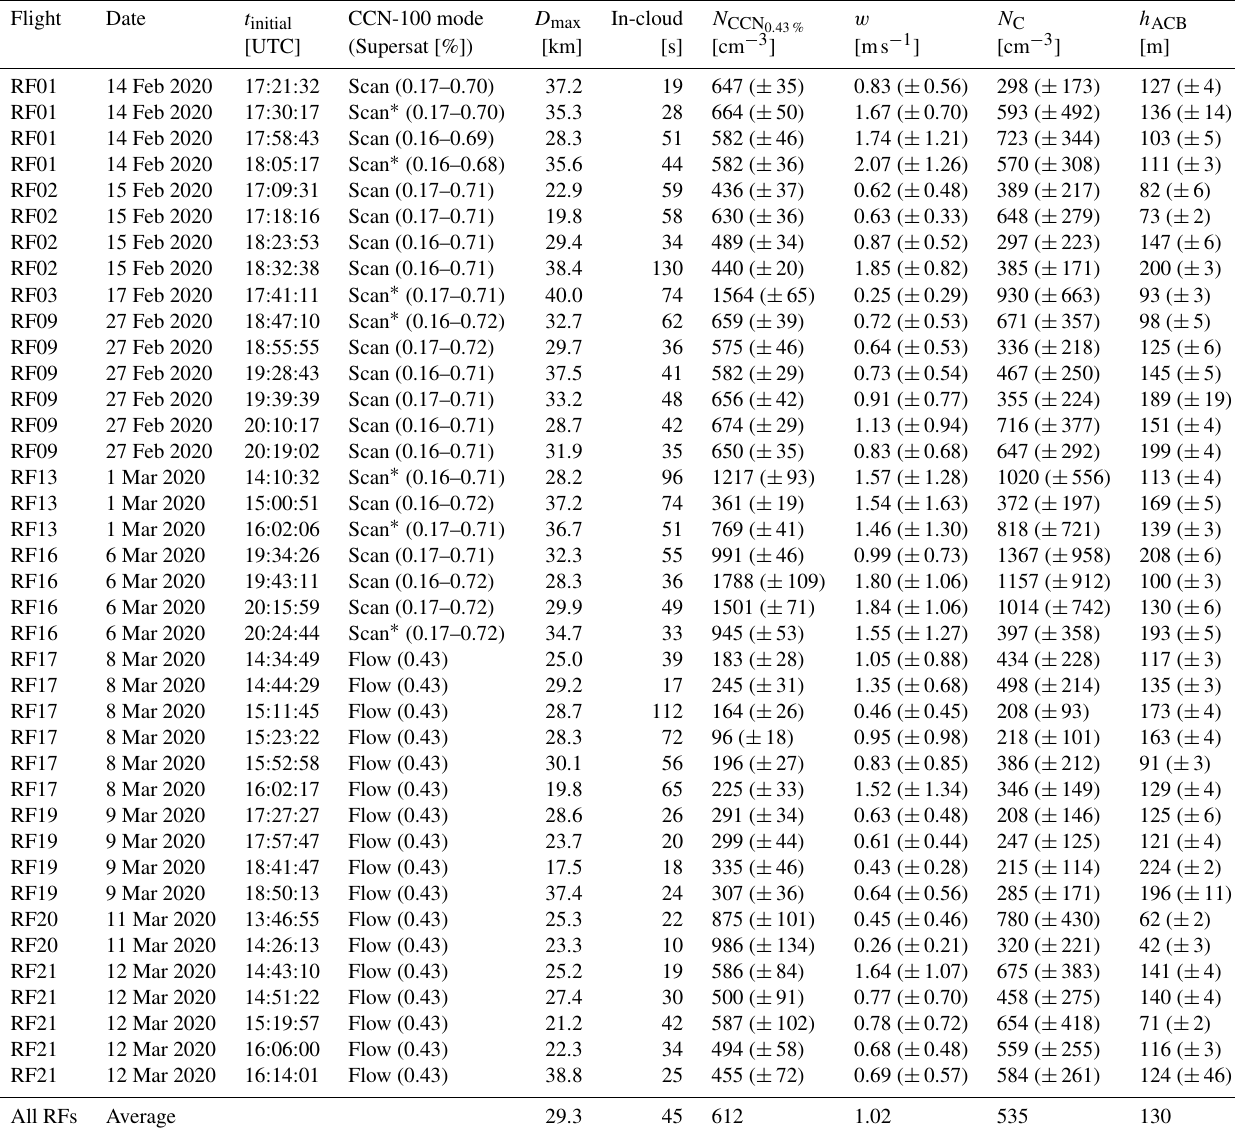
Table 1. All pairs consisting of serial below-cloud-base (BCB) and above-cloud-base (ACB) legs during the February–March 2020 deploy- ment. Mean values and standard deviation in parentheses for w and N C from ACB cloud portions and N CCN the maximal distance of cloud measurements to the aerosol measurements, and h ACB is the height above cloud base with standard deviation in